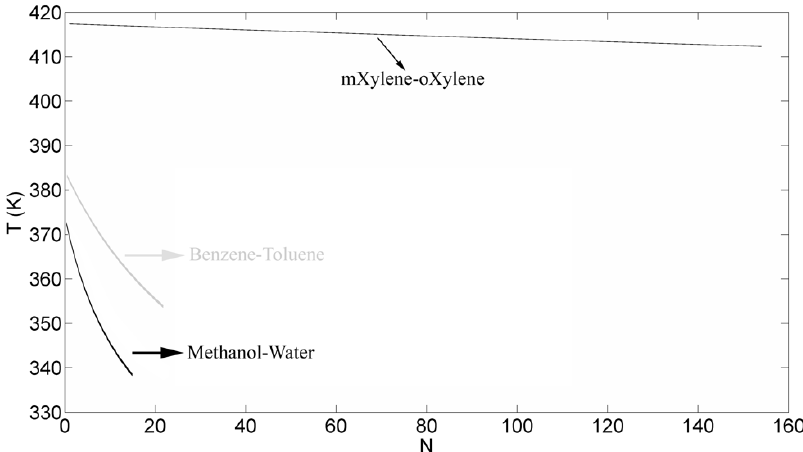
Figure 5. Predicted solution temperature by graphical model for conditions in Table